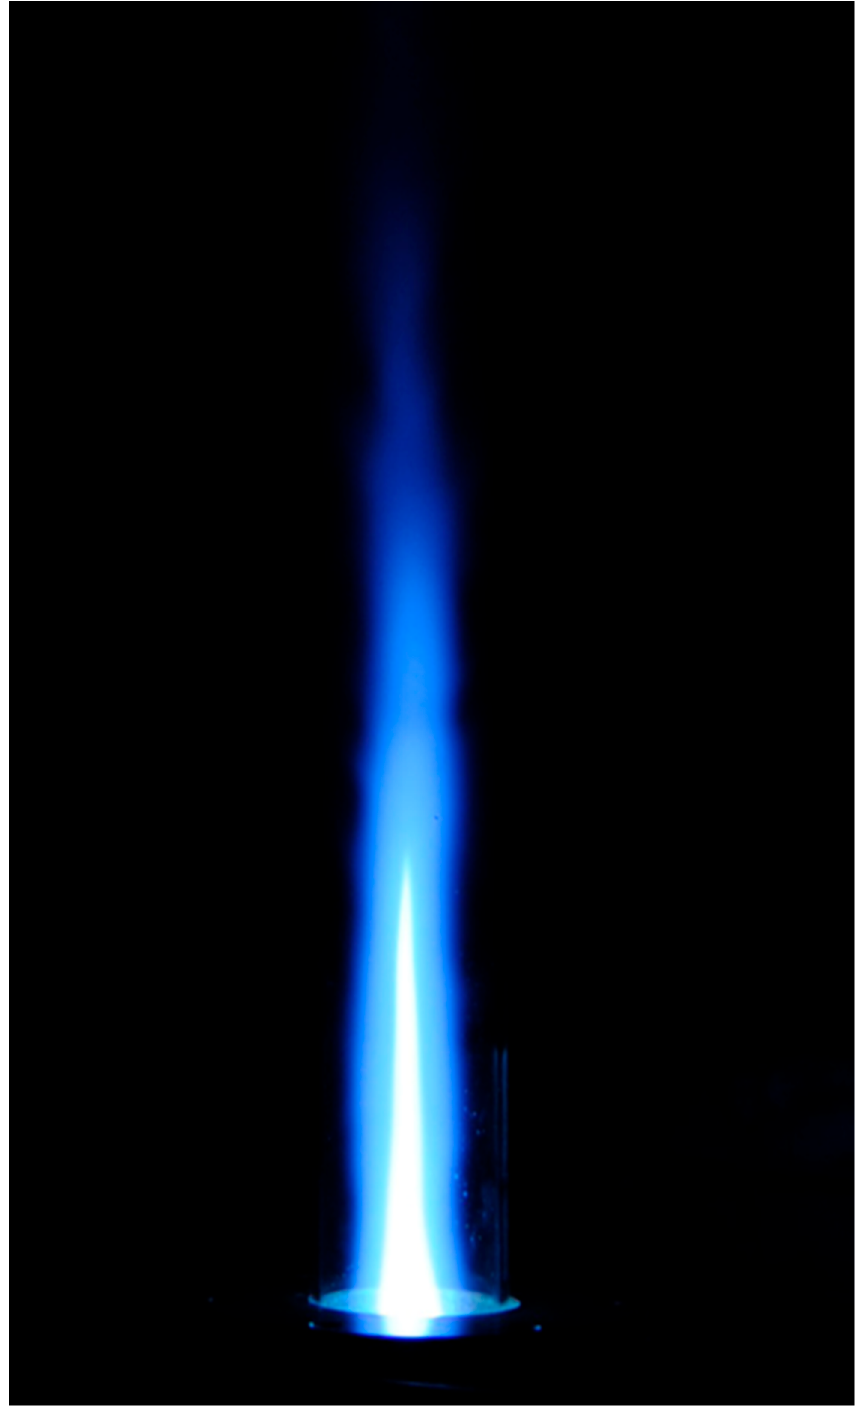
Figure 1. Photographs of the CO 2 microwave torch plasma within a quartz tube at a microwave operating at 3 kW. The internal diameter and length of the quartz tube were 26 mm, length = 300 mm, respectively.